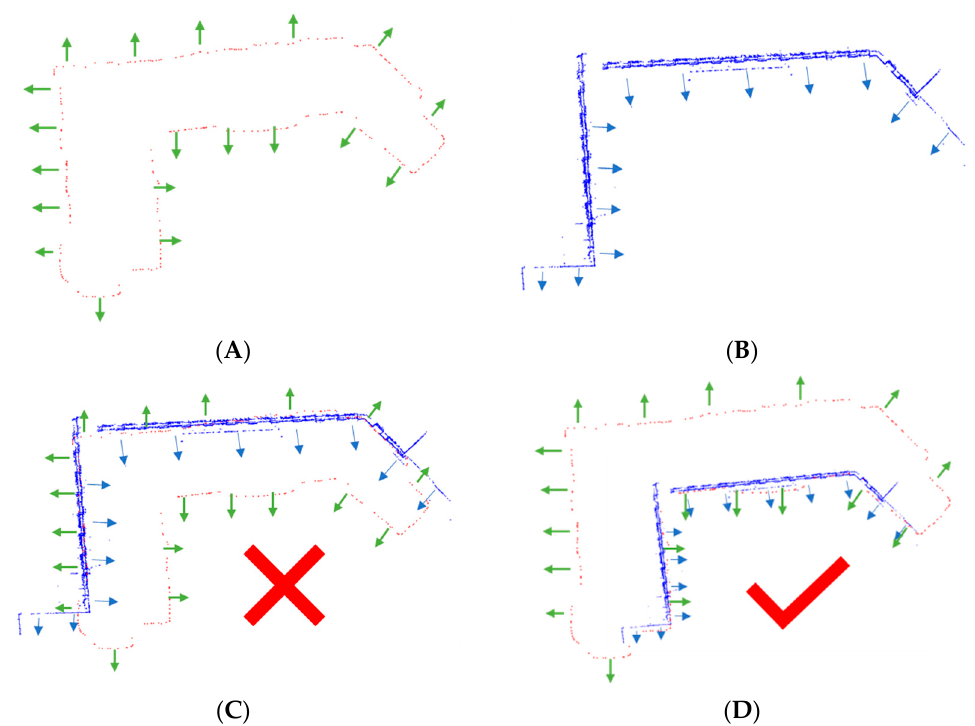
Figure 3. Illustration of the alignment procedure. ( A ) The 2D boundary points from LiDAR (red points) and their normal N P (green lines with arrows). ( B ) The 2D façade points (blue points) and their normal N M (blue lines with arrow). ( C ) An incorrect alignment result due to ambiguities, as seen by the large difference between the normal directions in the overlapping part of the two point clouds. ( D ) A correct alignment result as seen by the high similarity between the normal directions of points in the overlapping part.